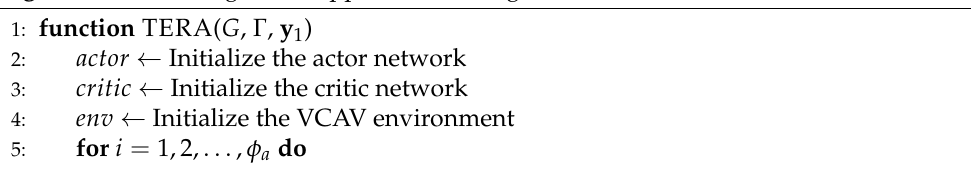
Algorithm 2 Learning-based approximation algorithm for